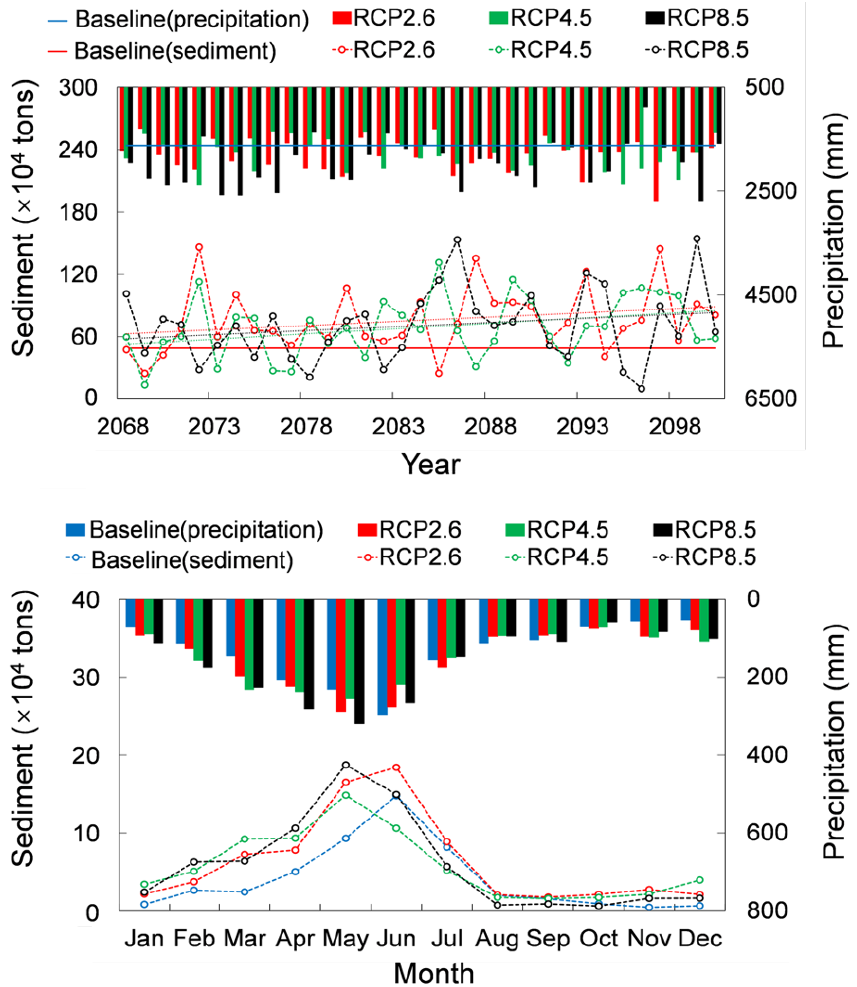
Figure 8. The inter- and intra-annual (monthly) variability in the sediment transported with water out of reach at Jiekou (estuary of Xin’anjiang River) under different climate scenarios.